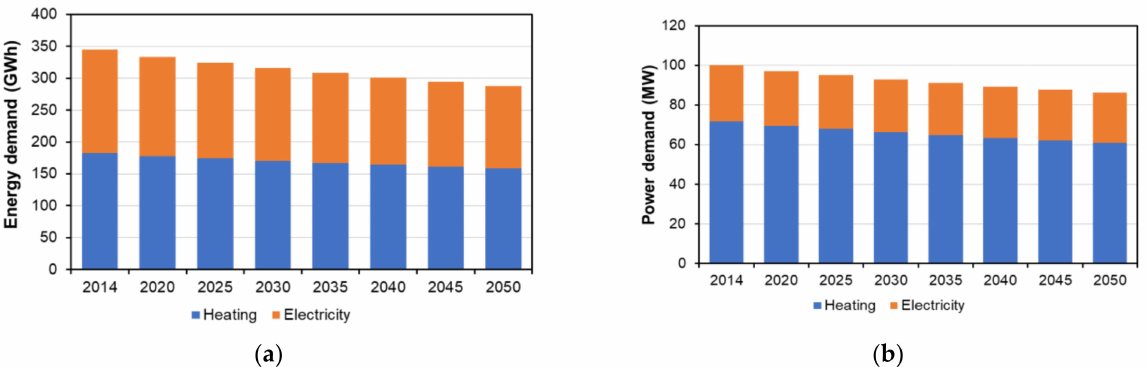
Figure 7. ( a ) Total energy demand of the constant building stock with normal development rate; ( b ) total power capacity demand of the constant building stock with normal development